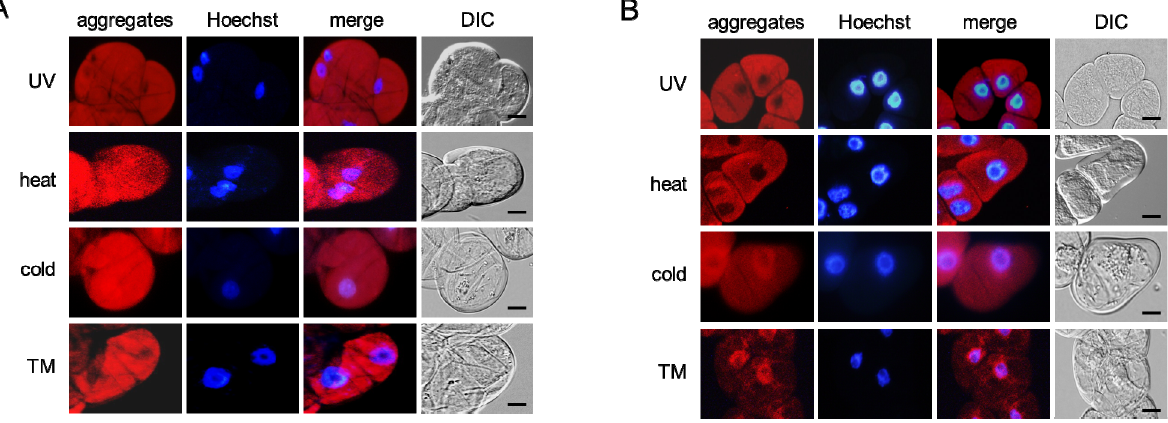
inhibitors completely suppressed misfolded protein aggregation in all of the grape and tobacco cultured cells exposed to the environmental stresses (Figure 5, UV radiation, heat stress, and cold stress). Figure 4. Environmental stresses induce misfolded protein aggregation in plant cells. ( A ) Grape cultured cells; ( B ) Tobacco cultured cells. The cells exposed to the environmental stresses were stained with Hoechst 33342 (Hoechst) and then with a ProteoStat Aggresome Detection Kit (aggregates). The red color and the blue color indicate the fluorescence of detected aggregates and stained nuclei, respectively. TM, tunicamycin; Merge, a merged image; DIC, an image observed under a DIC microscope; Scale bars, 20 μ m.